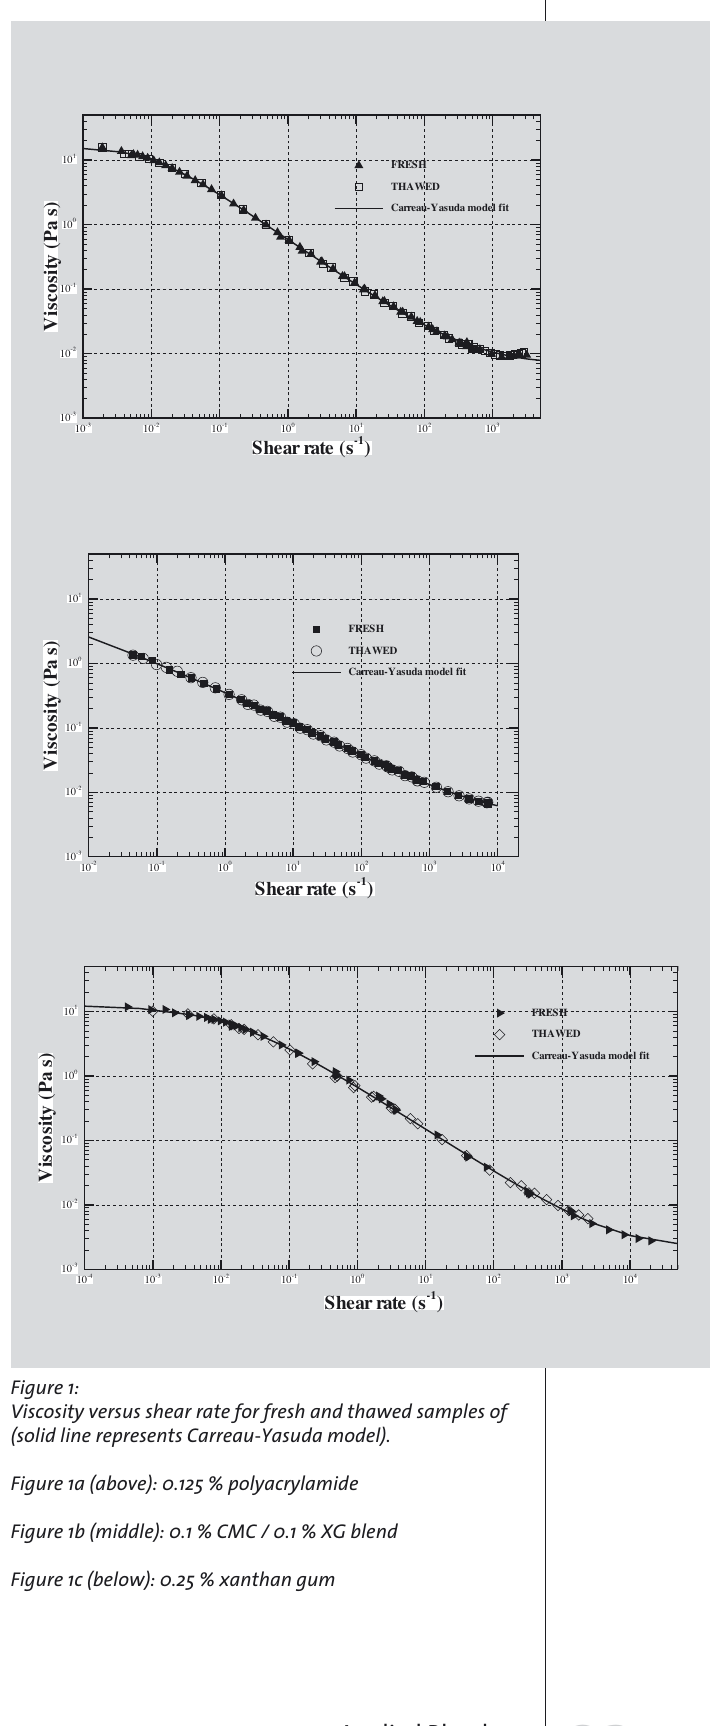
Figure 1: Viscosity versus shear rate for fresh and thawed samples of (solid line represents Carreau-Yasuda model). Figure 1a (above): 0.125 % polyacrylamide Figure 1b (middle): 0.1 % CMC / 0.1 % XG blend Figure 1c (below): 0.25 % xanthan